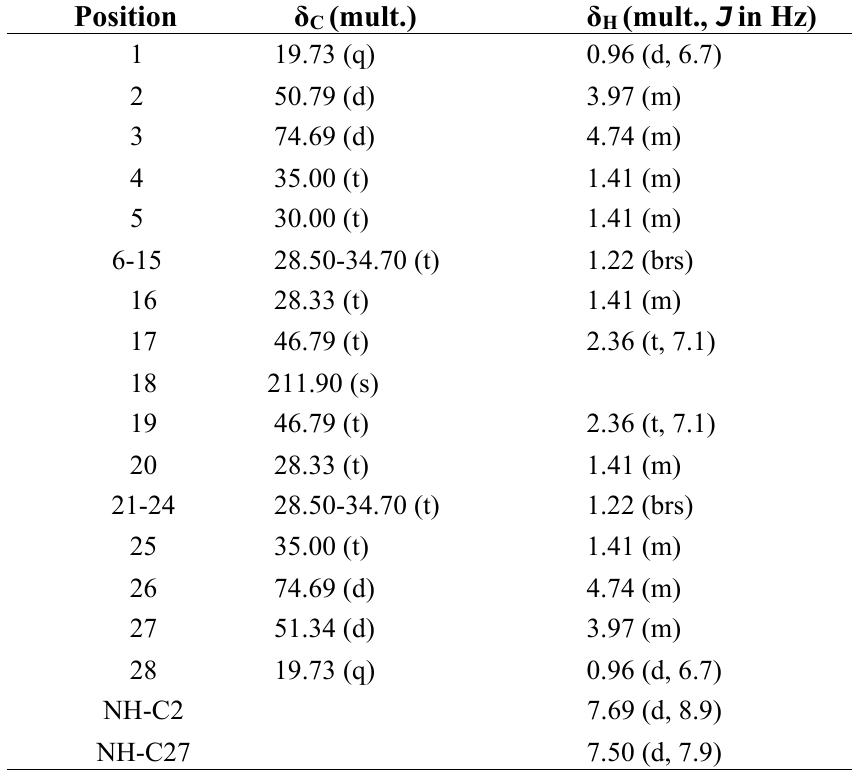
Table 2. 1 H- (500 MHz) and 13 C- (100 MHz) NMR of peracetylaglycone 2 a .